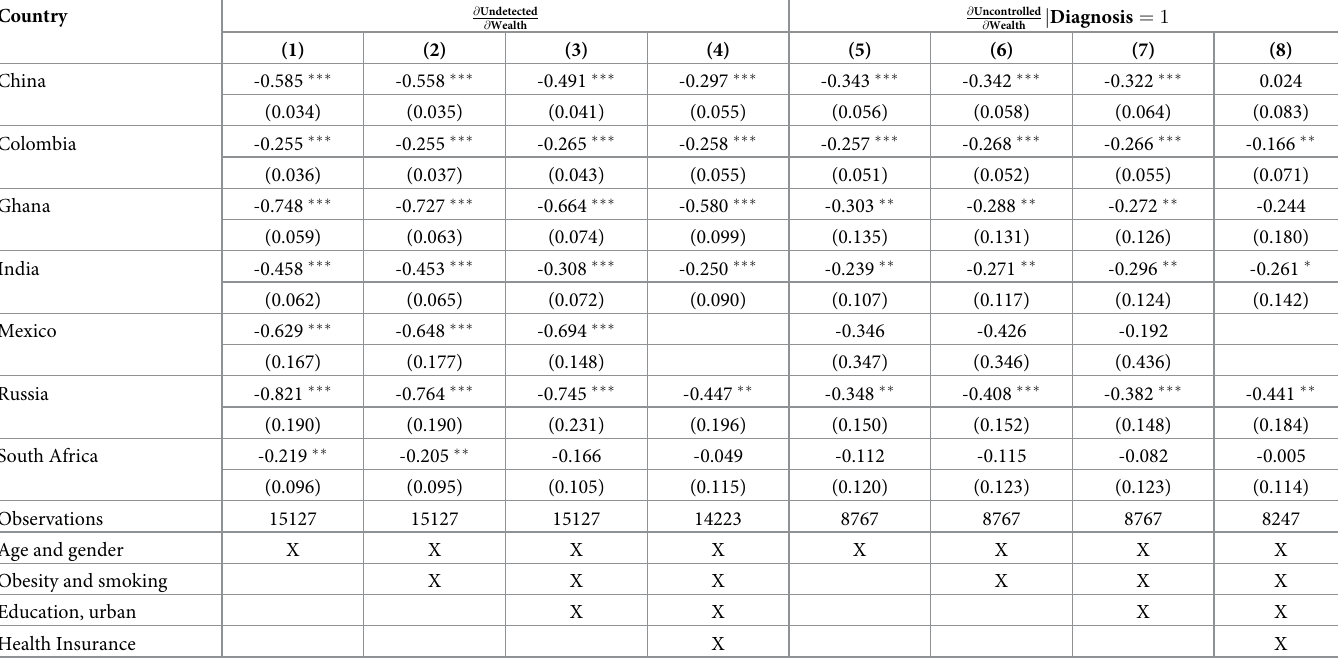
Table 2. Average marginal effects of wealth on undetected and uncontrolled HBP by country.